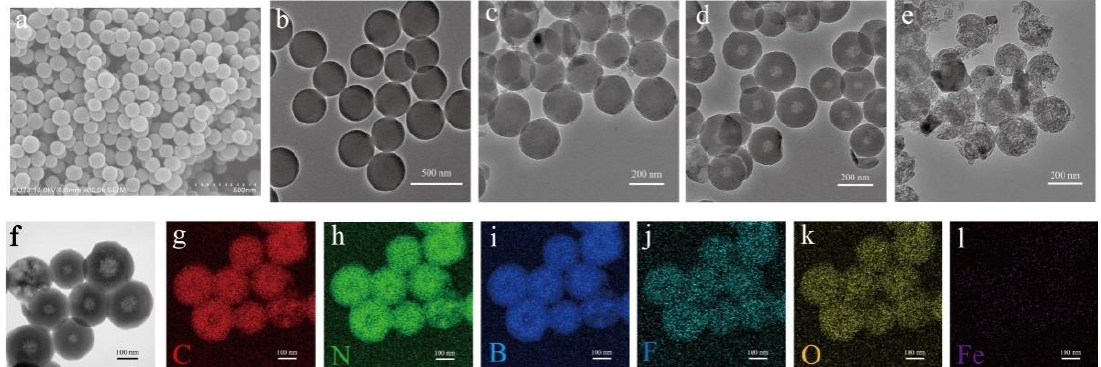
Figure 1. SEM ( a ) and TEM ( b ) images of boronate polymer nanosphere (BPN) nanoparticles. TEM images of CS 6-650 ( c ), CS 12-650 ( d ) and CS 18-650 ( e ). High-angle annular dark-field imaging scanning transmission electron microscope (HAADF-STEM) image ( f ) and corresponding energy-dispersive X-ray (EDX) mappings ( g–l ) of CS 12-650 .